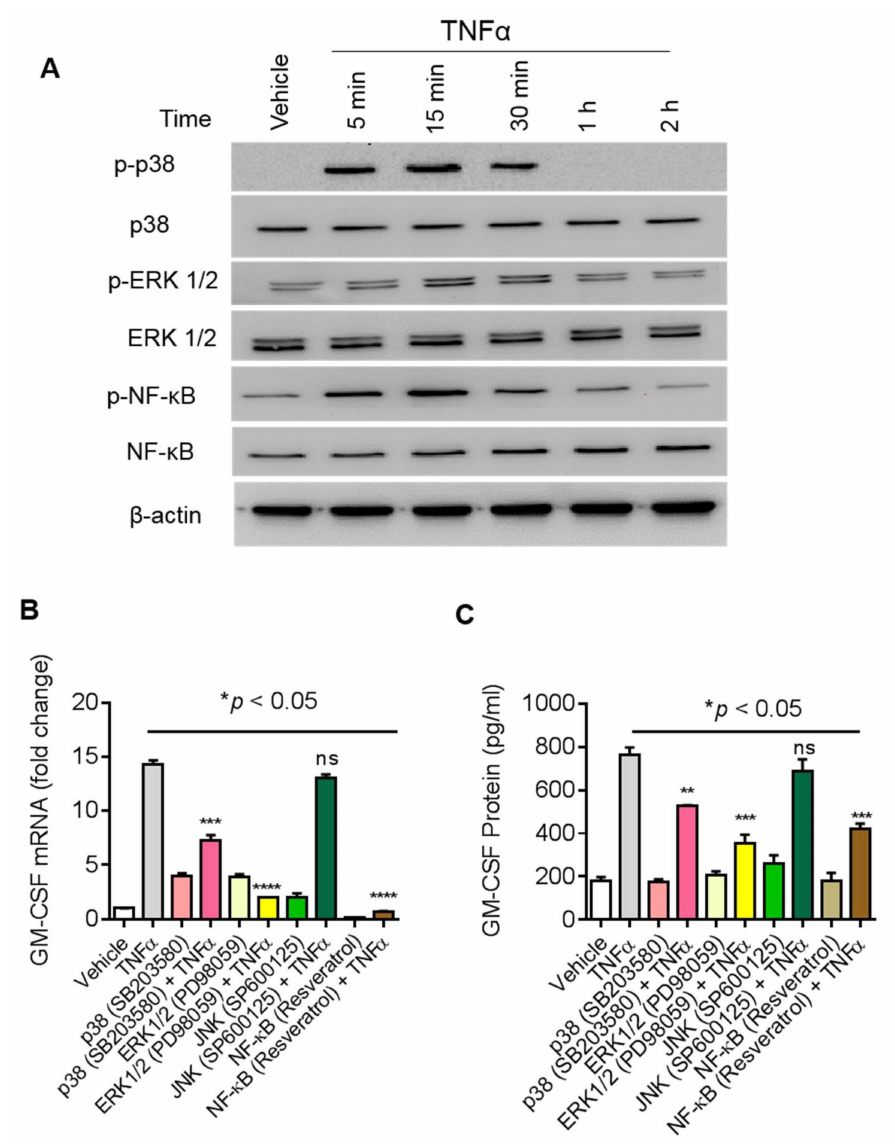
Figure 4. E ff ect of MAPK and NF- κ B pathway inhibitors on TNF α induced GM-CSF production in MDA-MB-231 cells. ( A ) TNF α activates the MAPK / NF- κ B signaling pathway. MDA-MB-231 cells were treated with TNF α for di ff erent time points and cell lysates were prepared as described in Materials andMethods. Sampleswererunondenaturinggels. Phosphorylatedp38MAPK,ERK1 / 2, andNF- κ Bare depicted in the upper panels and total respective proteins are shown in the lower panels. MDA-MB-231 cells were pretreated with p38 inhibitor (SB203580, 10uM; InvivoGen, San Diego, CA, USA) or ERK1 / 2 inhibitor (PD98059, 10 µ M; InvivoGen, San Diego, CA, USA) or JNK inhibitor (SP600125, 10 µ M) or NF- κ B inhibitor (resveratrol, 1 µ M) for 1 h and then treated with TNF α for 8 h. Cells and supernatants were collected. ( B ) Cells were used for the isolation of total RNA to assess the GM-CSF gene expression by real-time PCR. ( C ) Secreted levels of GM-CSF protein were determined in supernatants by ELISA. The results obtained from three independent experiments are shown. All data are expressed as mean ± SEM ( n ≥ 3). **** p < 0.001 versus TNF α without respective